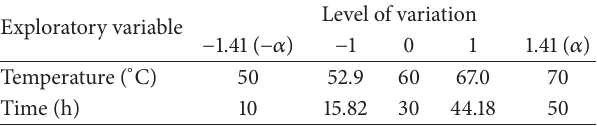
Table 2: Central composite design (CCD) with observed response for mass loss (g).